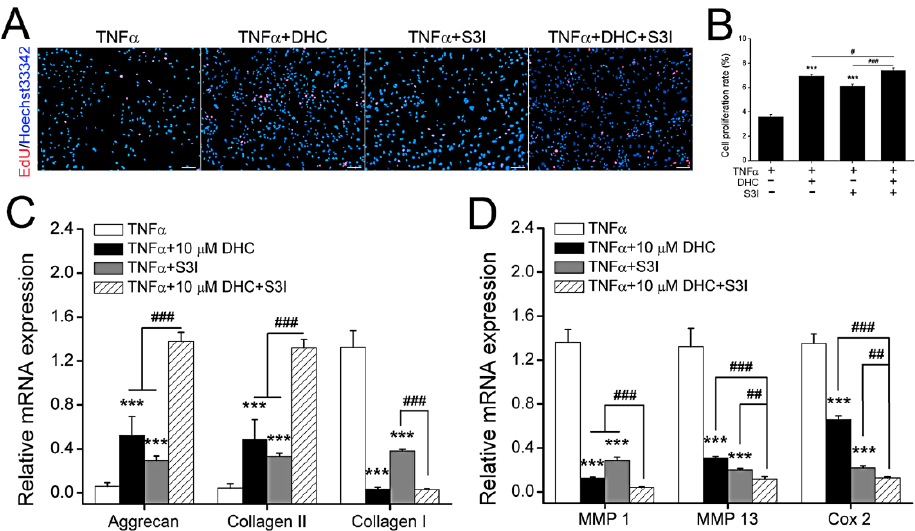
Figure 5. Dehydrocorydaline (DHC) regulated cell proliferation and extracellular matrix (ECM) synthesis in the TNF α -treated human chondrocytes via JAK1-STAT3 pathway. ( A ) EdU staining for detecting cell proliferation and ( B ) quantified results. The mRNA expression levels of ( C ) aggrecan (Agg), type I/II collagen, and ( D ) degrading enzymes such as matrix metalloproteinase 1/13 (MMP1/13) and prostaglandin-endoperoxide synthase 2 (PTGS2, also known as Cox2) in the TNF α -treated human chondrocytes. Scale bar = 100 µ m. Data are presented as mean ±